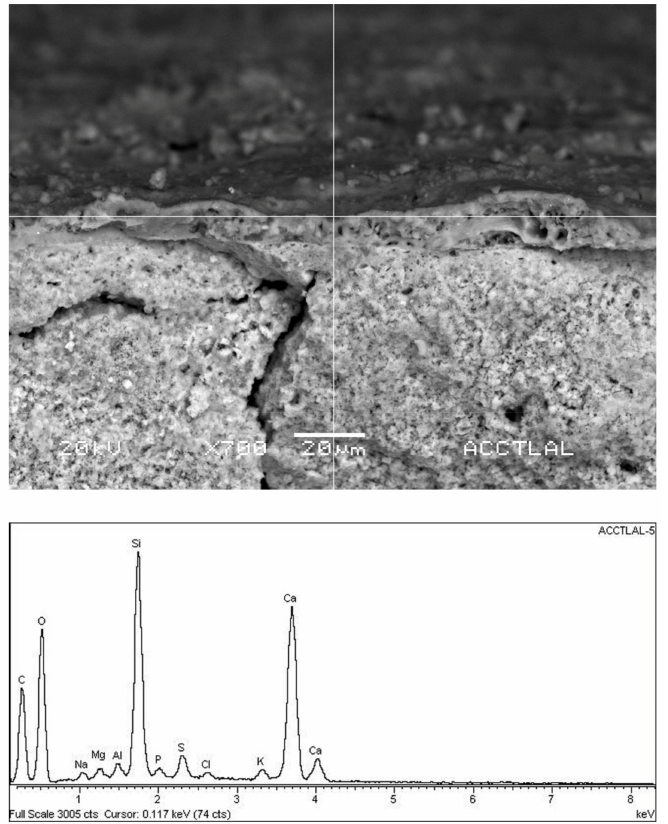
Figure 11. SEM image of Tlaltizapan blue. A dark coating enriched in Si can be observed at the